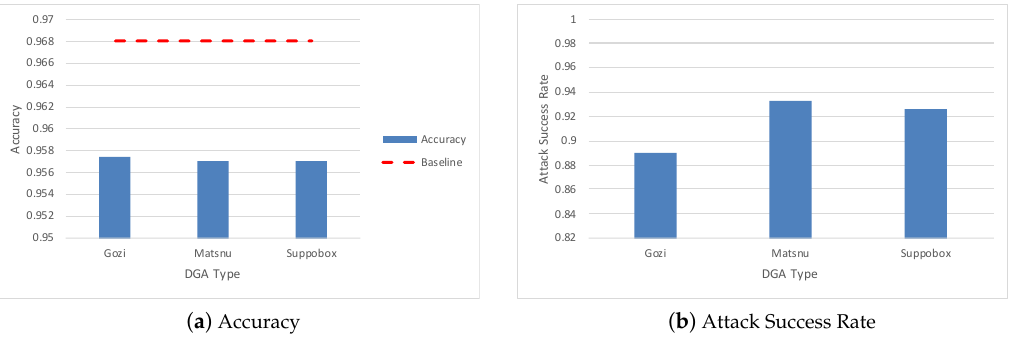
Figure 5. ( a ) The BA of Word-trigger backdoor attack based on different DGAs and ( b ) the ASR of Word-trigger backdoor attack based on different